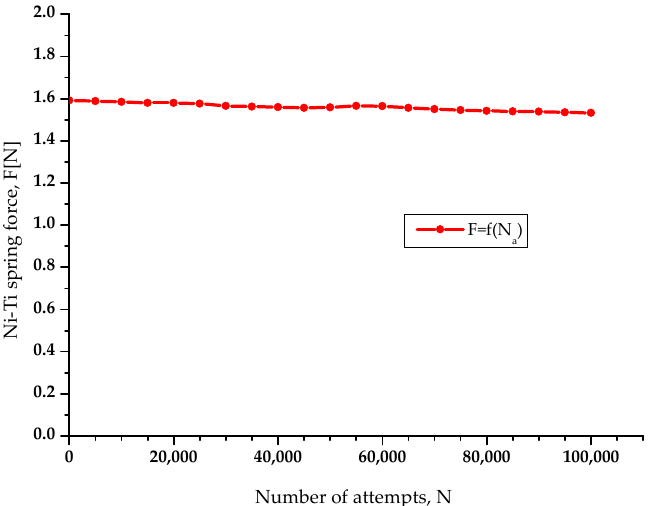
Figure 4. The force variation generated by the Ni-Ti during the test period (19 days of continuous operation) at the applied electric current, I 1 .